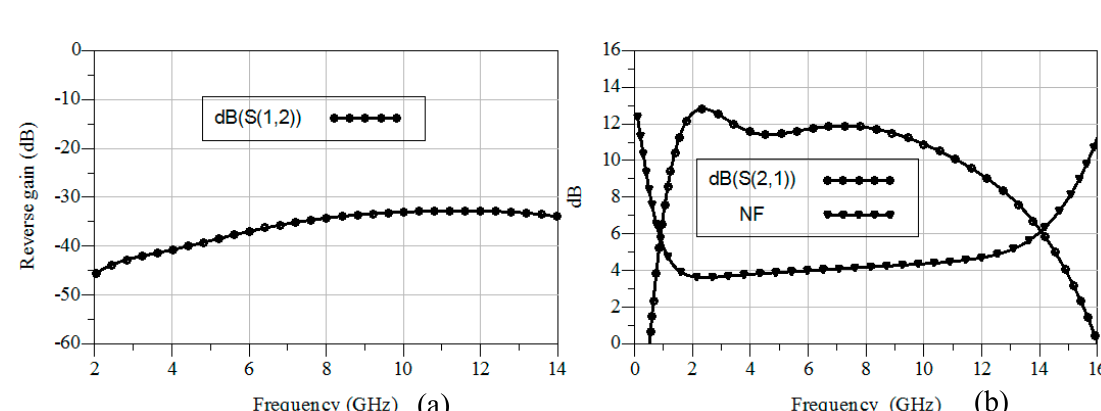
Figure 7. Simulated results of: ( a ) compression point 1 dB, and ( b ) Interception point (IP3).